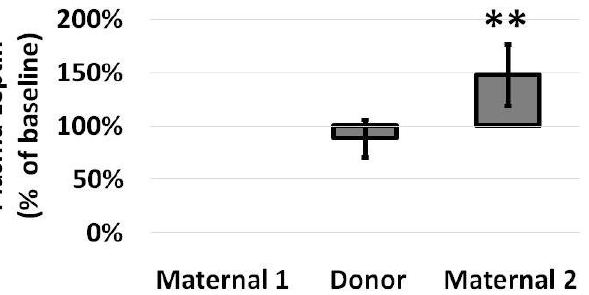
Figure 3. Plasma leptin levels, as a percentage of baseline values, among infants at the end of a week of maternal milk (all values 100% by definition), an intervening week of donor milk and a final week of maternal milk. Leptin levels only increased during the administration of maternal milk. Data are presented as mean (SD) with N = 8 and ** p < 0.01 for Maternal 2 versus Donor. Overall, plasma leptin levels significantly correlated with the leptin content of the breast milk the infants had received earlier that same day (Figure 4). By simple linear regression, there was no correlation between leptin levels and the volume of breast milk consumed (R = 0.04, p = 0.84) or the infant’s incremental weight gain (R = 0.37, p = 0.08).